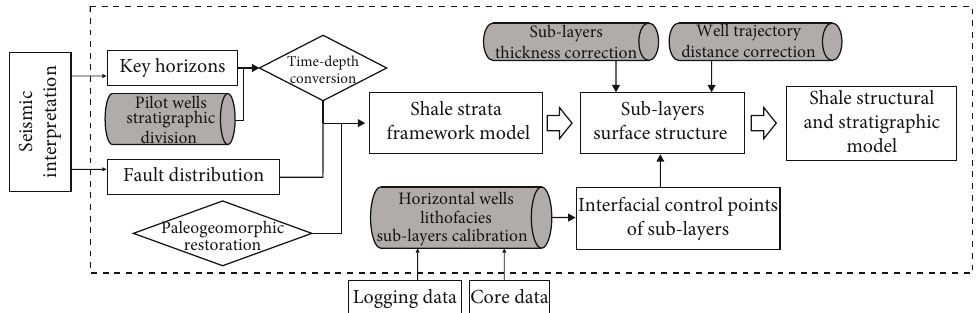
Figure 4: A structure-stratigraphic modeling process of shale gas based on the lithofacies sublayer calibration on horizontal